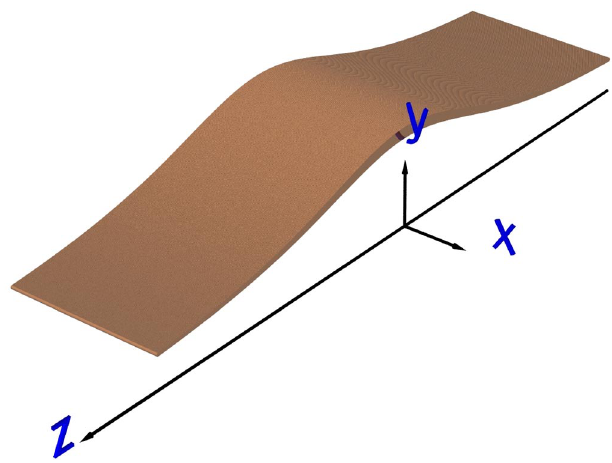
FIG. 6. (Color) A beam trajectory near a wall. Only half of the wall extending into the region of negative values of x is